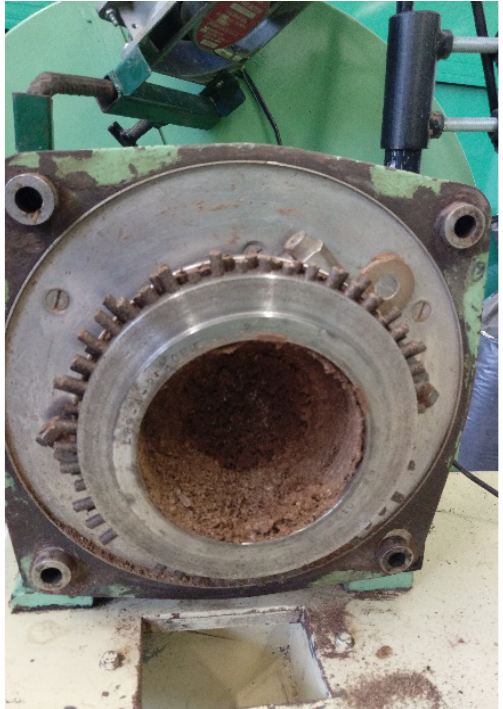
Fig. 2. The ring-die for the densification